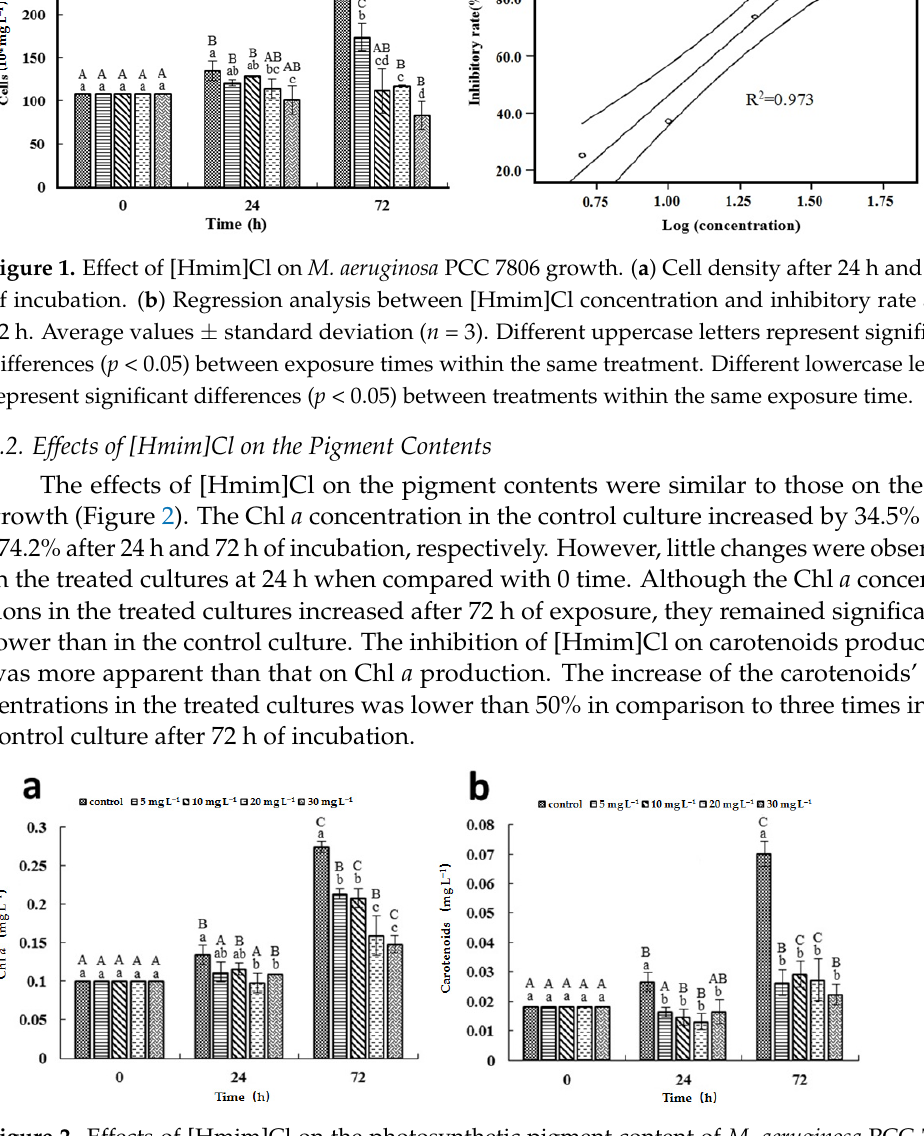
Figure 2. Effects of [Hmim]Cl on the photosynthetic pigment content of M. aeruginosa PCC 7806. ( a ) Chl a concentration; ( b ) carotenoids concentration. Different uppercase letters represent significant differences ( p < 0.05) between exposure times within the same treatment. Different lowercase letters represent significant differences ( p < 0.05) between treatments within the same exposure